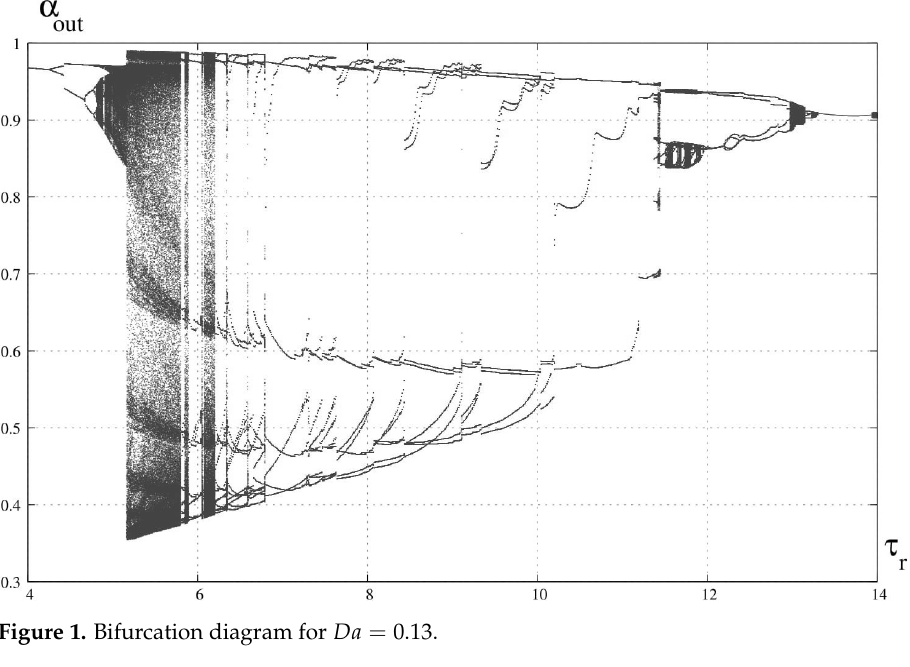
Figure 1. Bifurcation diagram for Da = 0.13.